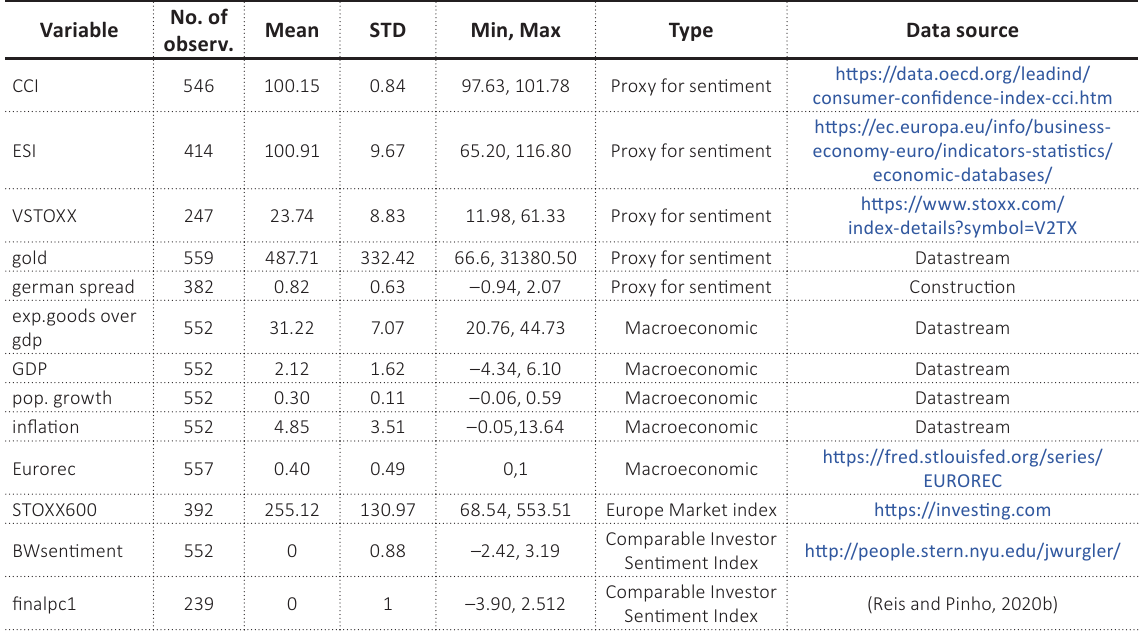
Table 1. Descriptive statistics and definition of